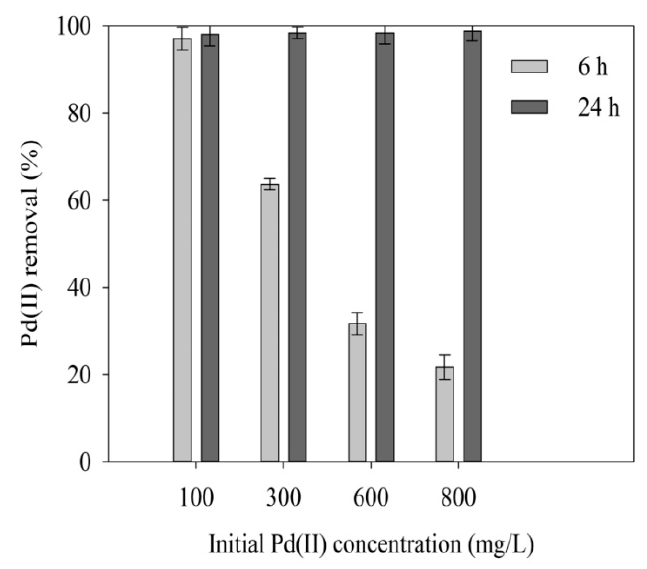
Figure 5. Pd(II) removal under different initial Pd(II) concentrations measured at both experimental time of 6 h and 24 h.